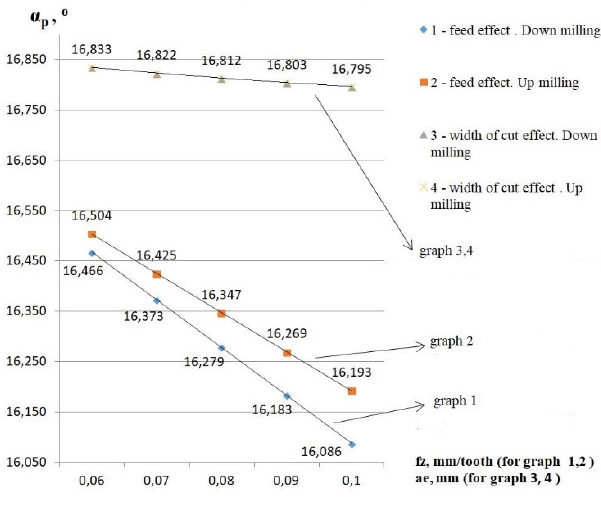
Fig. 7 . Graph plots and equations of the kinematic clearance angle α р depending on depth per tooth and radial width of cut with the recommended cutting data a e =0,1 mm and f z =0,007 mm/tooth for micro end mills with GF500T by Guhring with d